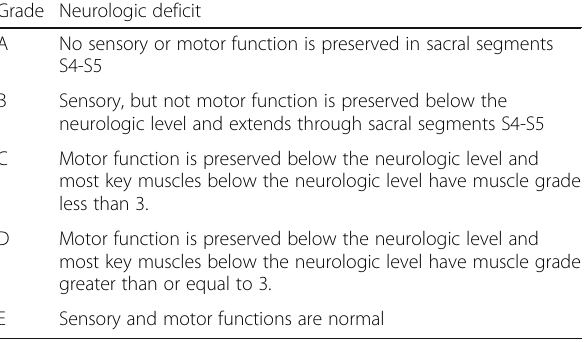
Table 1 American Spinal Injury Association classification 11 Grade Neurologic